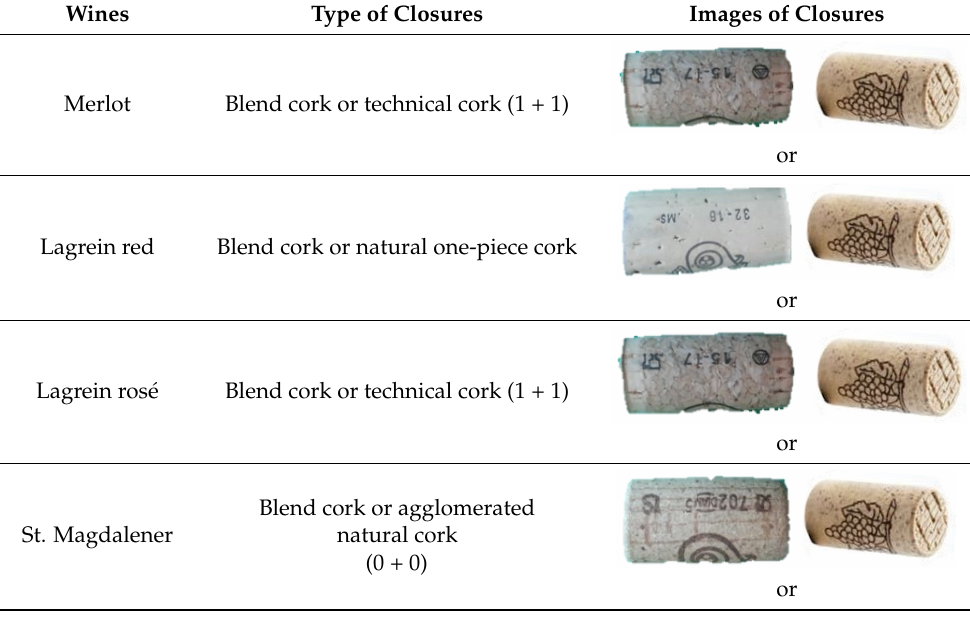
Merlot Blend cork or technical cork (1 + 1)